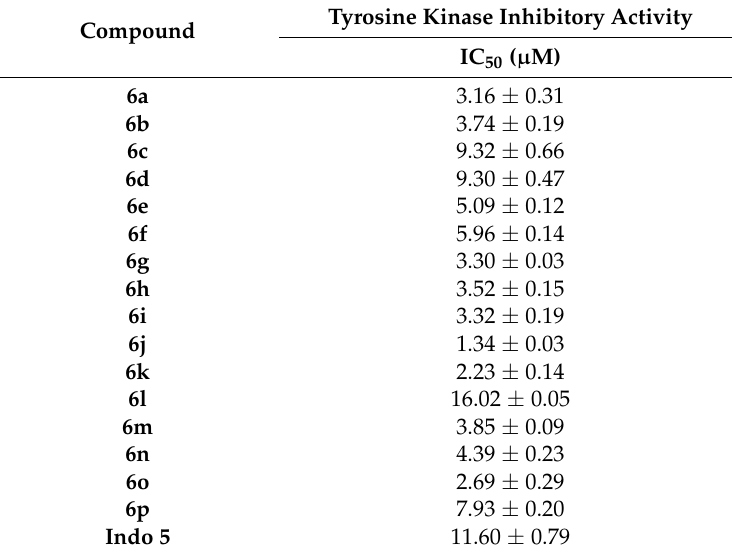
Table 1. The tyrosine kinase inhibitory activity of compounds 6a ~ 6p .